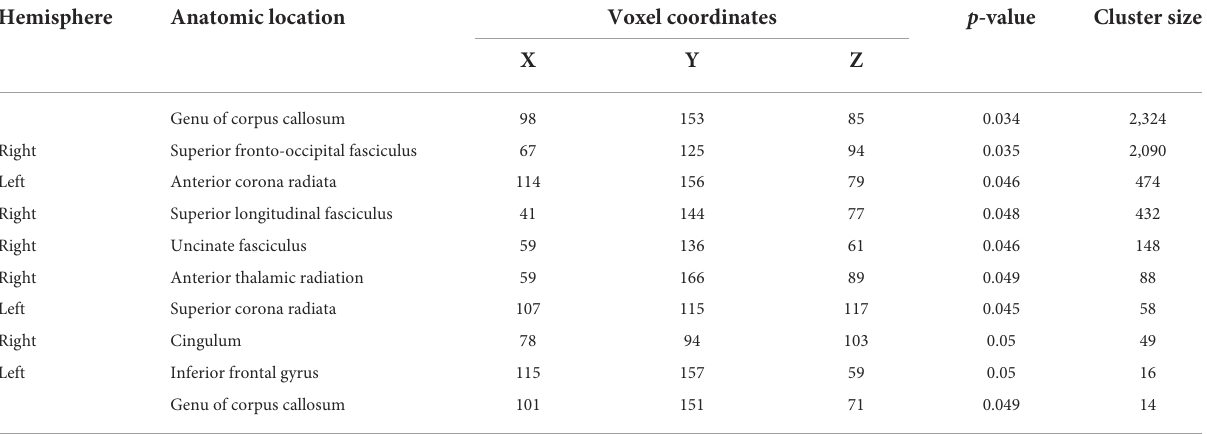
TABLE 4 Anatomic location of decreased FA clusters in the TBI groups compared to